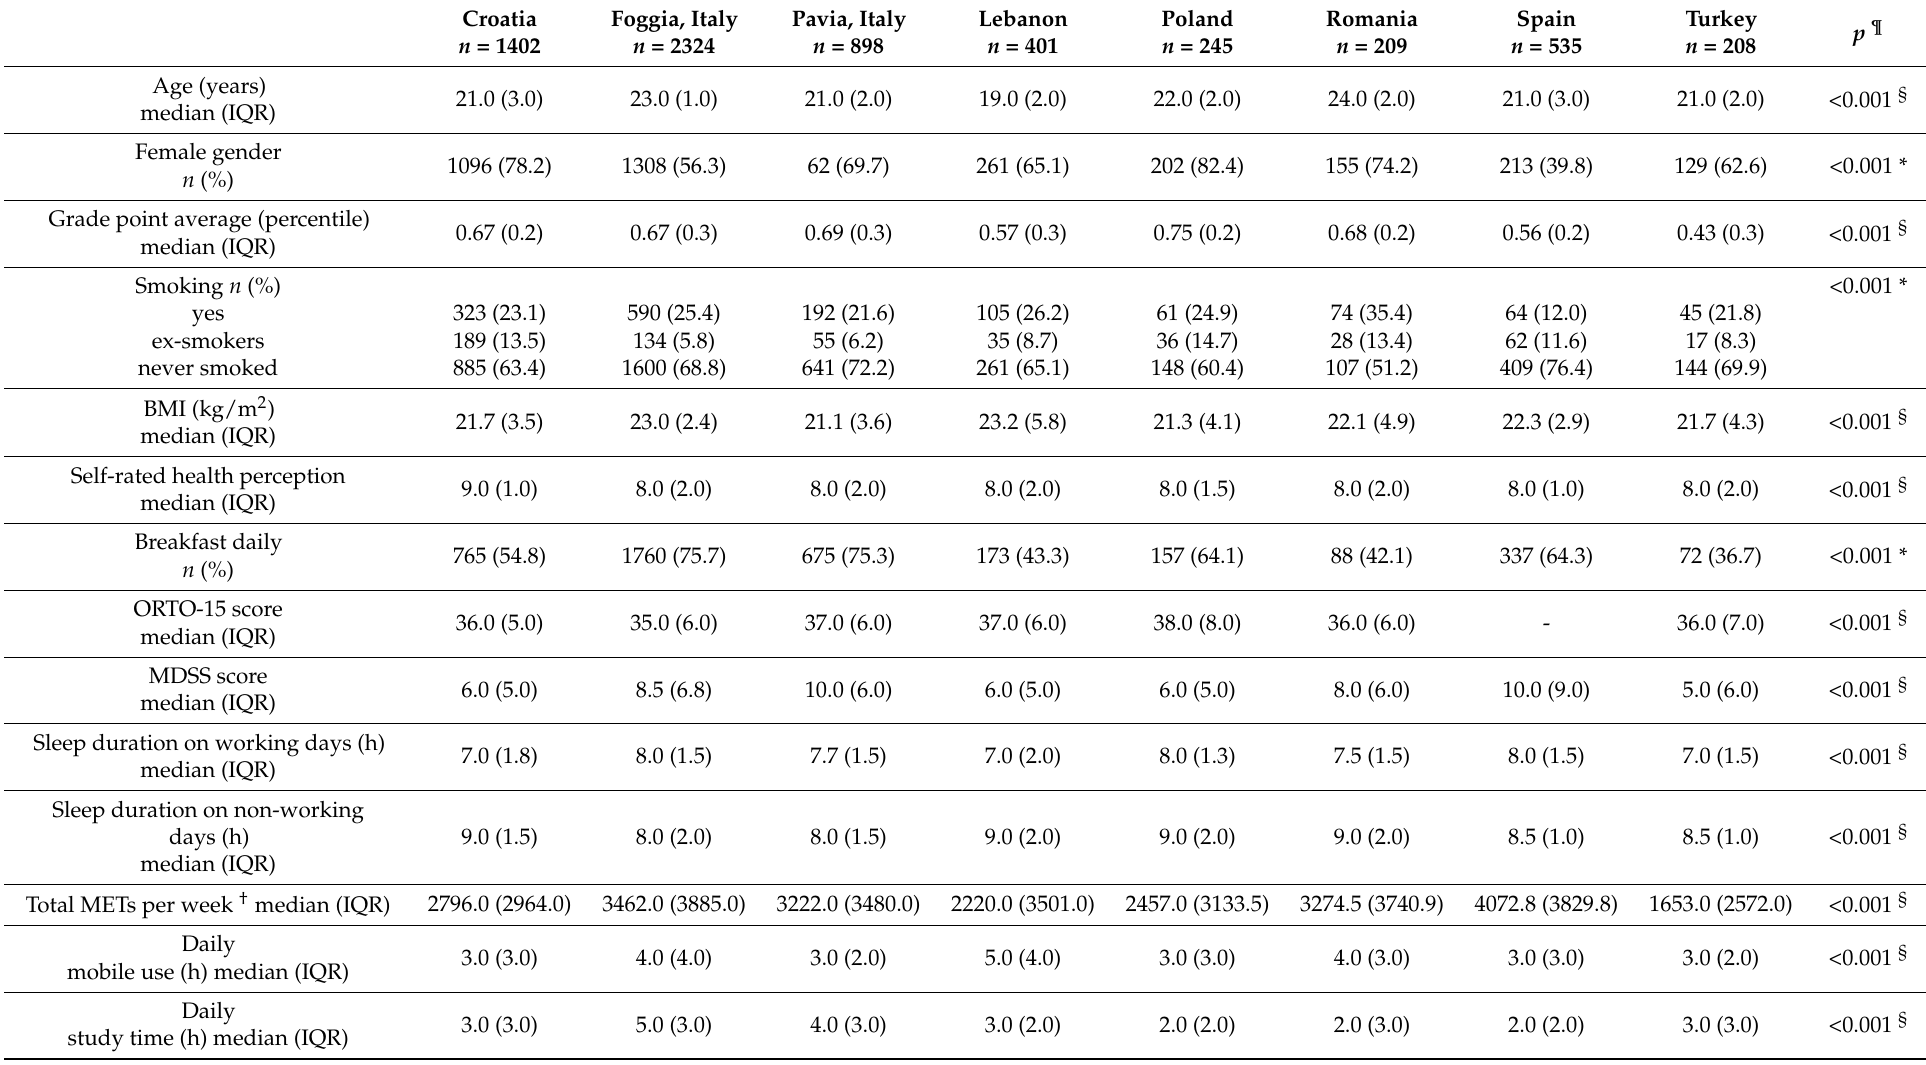
Table 1. Overall lifestyle characteristics of students according to the study